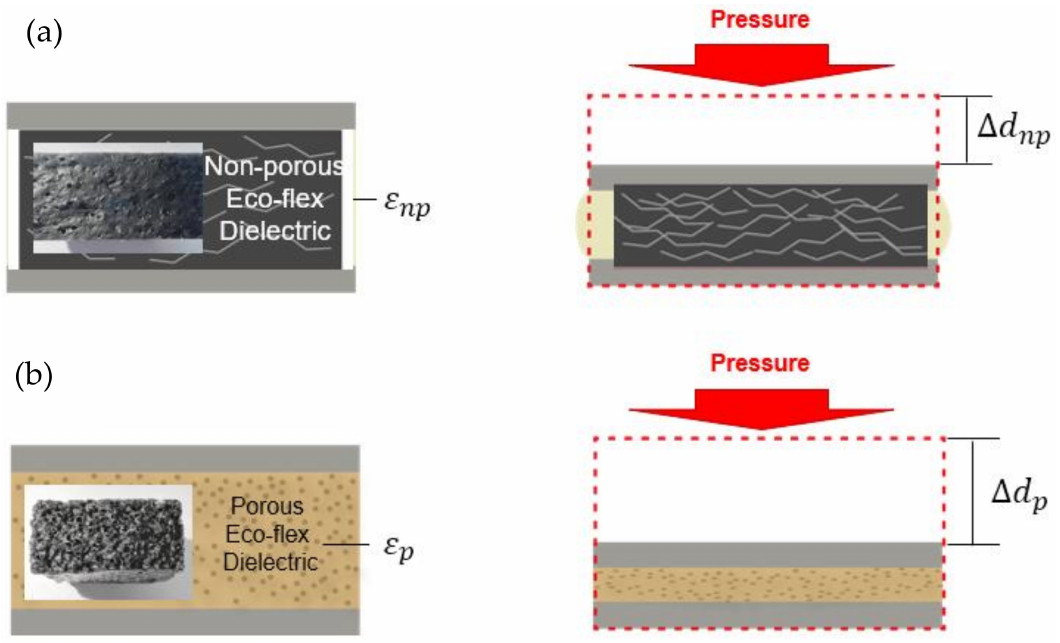
Figure 10. Schematic illustrations of the proposed pressure sensor ( a ) CNTs + Ecoflex; ( b ) CNTs + Sugar +